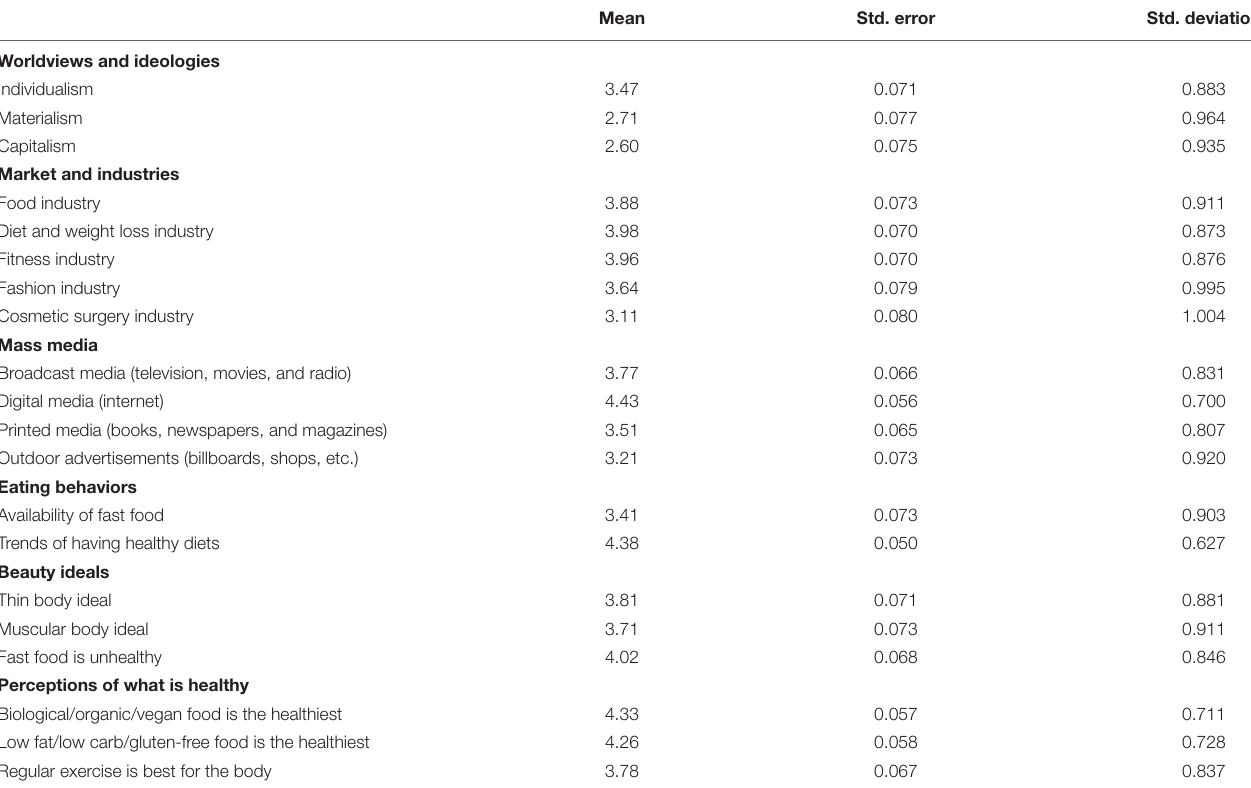
TABLE 2 | Mean scores, SE, and SD for all factors of the questionnaire.